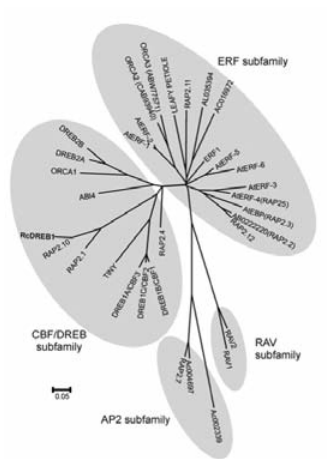
Figure 2. Phylogenetic analysis of RcDREB1 with other AP2/ERF proteins. The RcDREB1 grouped with the CBF/DREB subfamily. The amino acid sequences of the AP2/ERF domains were aligned by Clustal W and the phylogenetic tree was constructed using MEGA 5 with Neighbor-Joining method. The tree includes AP2 domains available in GenBank and TIGR databases. Cut-off bootstrap values >50% were considered for the consensus